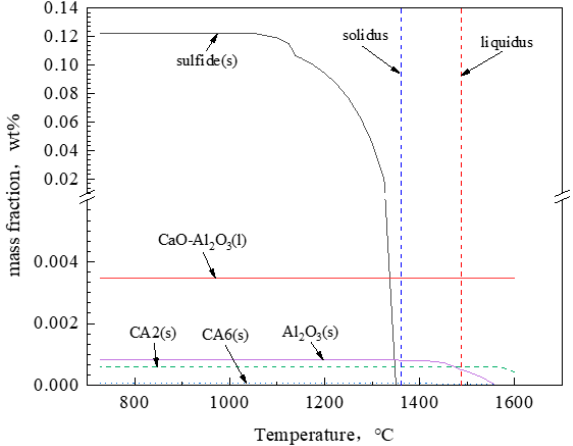
Figure 8. Inclusion content during solidification of sample S1.